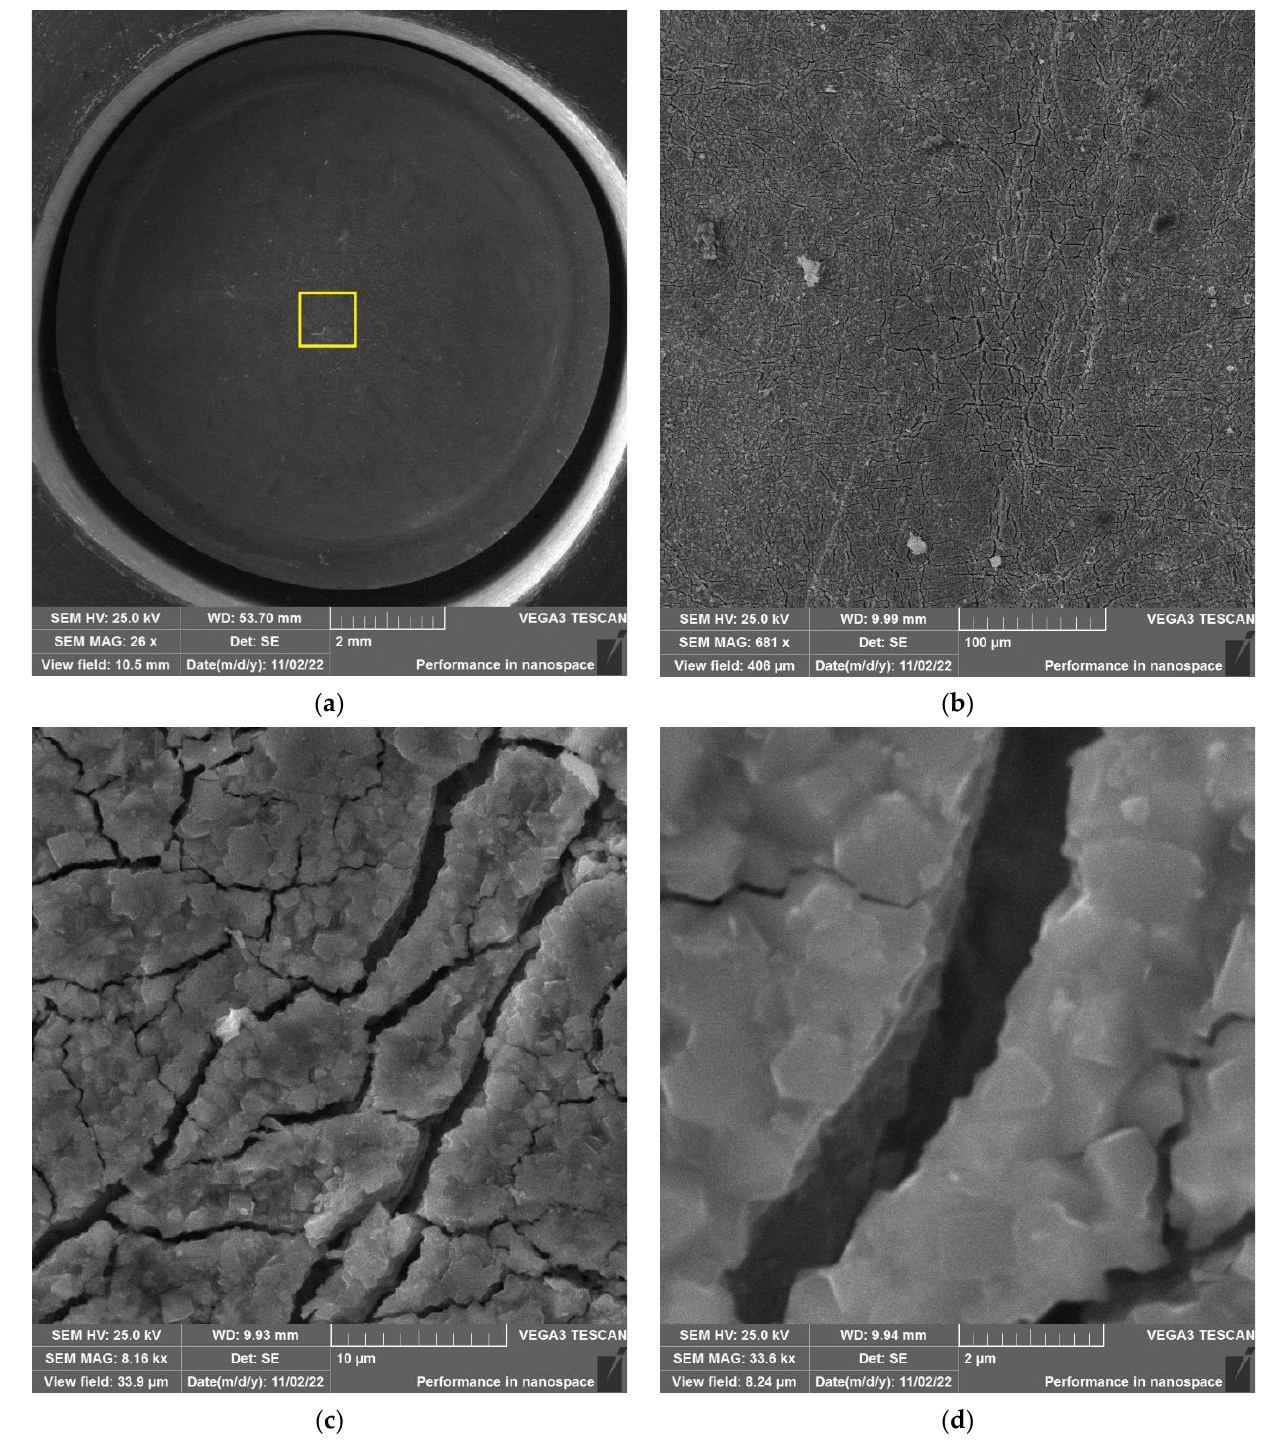
Figure 19. Surface of disk specimen № 10 (T irr = 550 °C, Table 4) at different magnifications after autoclave SCC tests with a load value of 650 N and additional loading up to 6102 N.